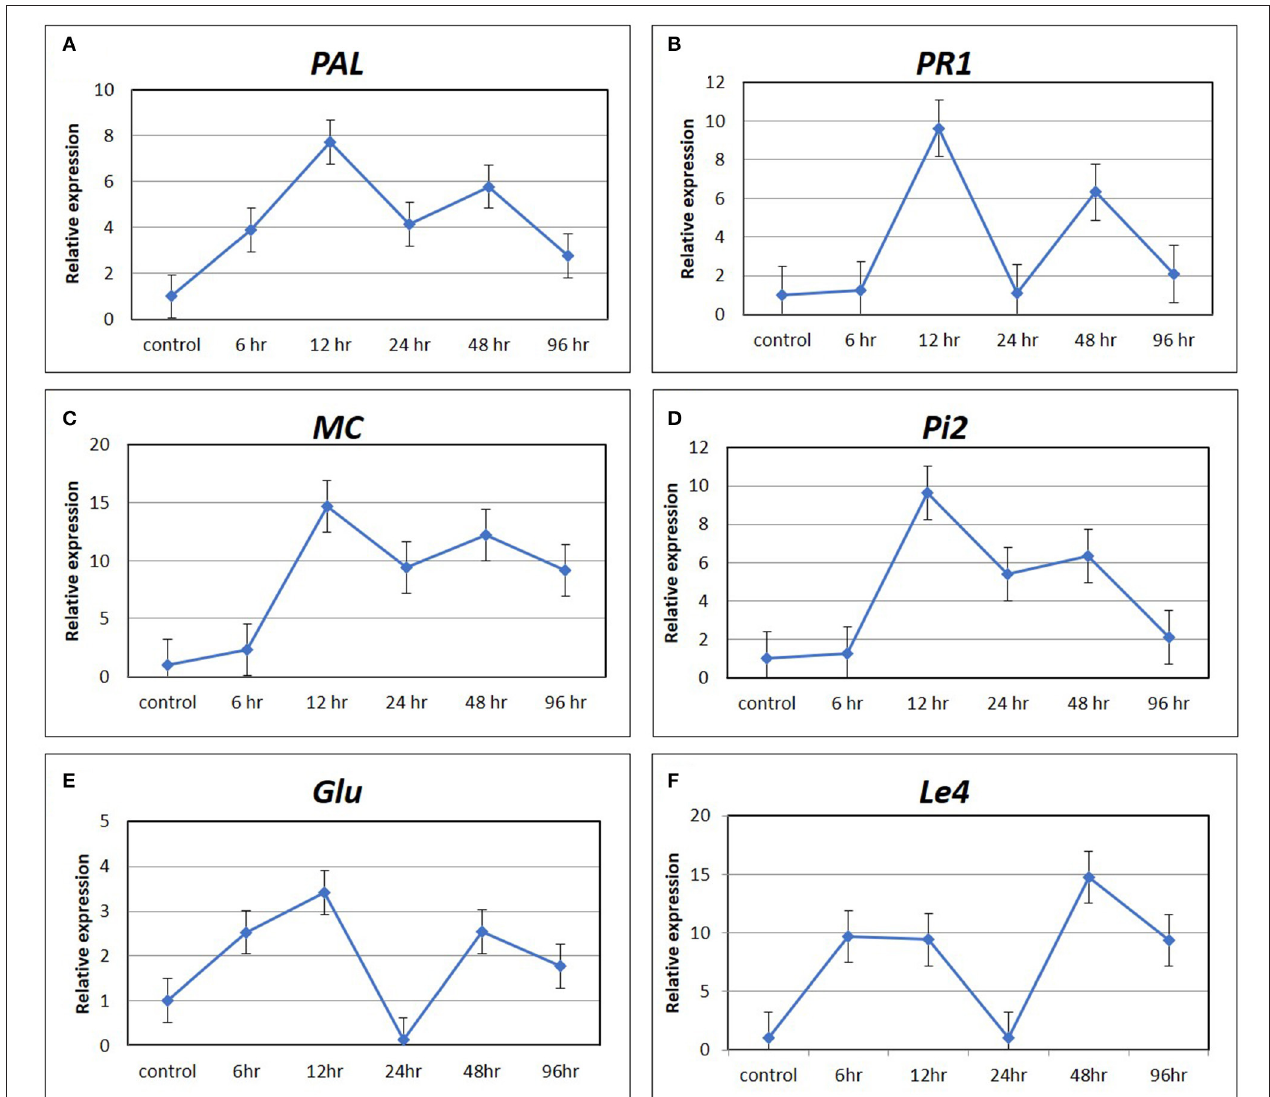
FIGURE 3 | The expression pattern of marker gene of defense signaling hormone transduction pathways by qRT-PCR (A) PAL and (B) PR1 of SA mediated signaling; (C) MC and (D) Pi2 of JA signaling; (E) Glu of ET mediated signaling; and (F) Le4 of ABA signaling.